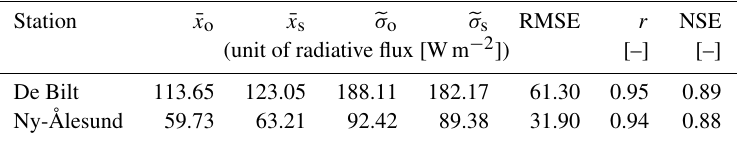
Table 6. Model performance measures for radiation disaggregation (R2 model). ¯ x o and ¯ x s denote the mean values of observed and disag- gregated shortwave radiation, respectively. The standard deviation of the observed ( e σ o ) and disaggregated ( e σ s ) time series are also specified. The root mean square error (RMSE), the correlation coefficient r , and the Nash–Sutcliffe model efficiency (NSE) are calculated using the observed and disaggregated time series for each